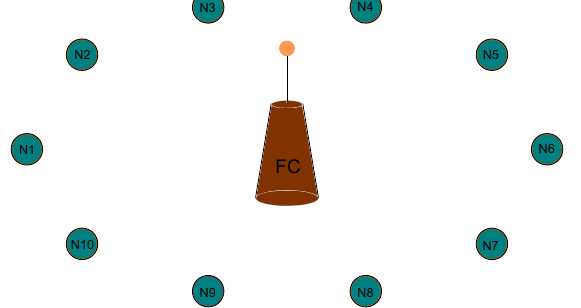
Figure 1. An example single hop WSN where an FC collects data from 10 EH